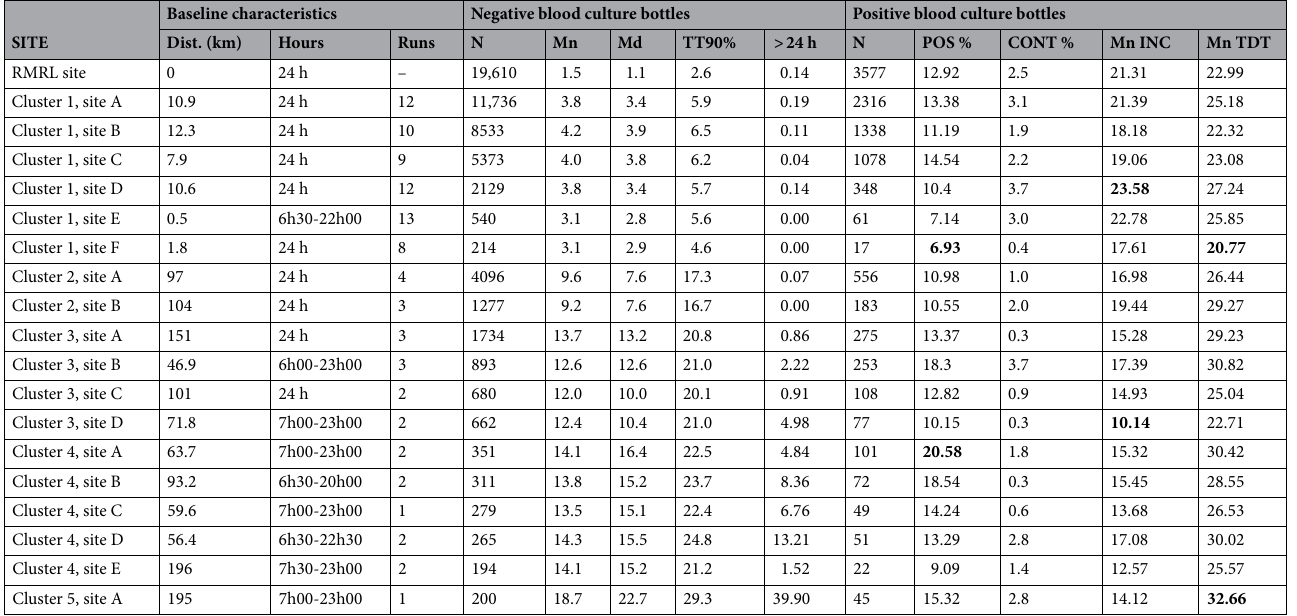
Table 1. Preincubation times for negative blood culture bottles for all study sites and incubation (INC) and total detection times (TDT) for positive blood culture bottles for all study sites. Time values are listed in hours and sites are presented in reverse order of testing volume. INC is defined as time from insertion into the automated blood system to growth detection and TDT is defined as time from collection to growth detection. The lowest and highest values for POS %, Mn INC and Mn TDT are presented in bold for emphasis. Dist: distance, N: number, Hours: hours of operation, Runs: daily number of couriers, Mn: mean, Md: